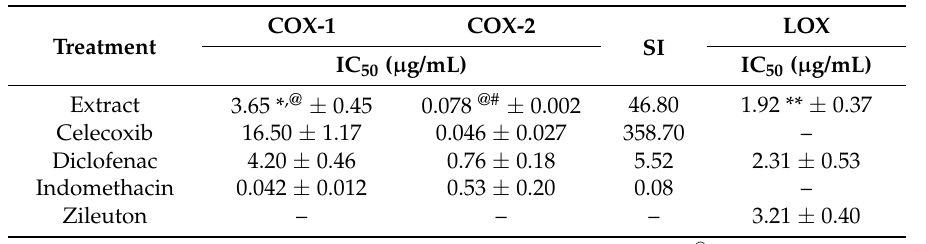
Table 3. Effect of A. zerumbet extract on the activities of COX-1, COX-2, and LOX enzymes, calculated as extract concentration that caused 50% inhibition of enzyme activity (IC 50 ). Celecoxib, diclofenac, indomethacin, and zileuton were used as positive controls.